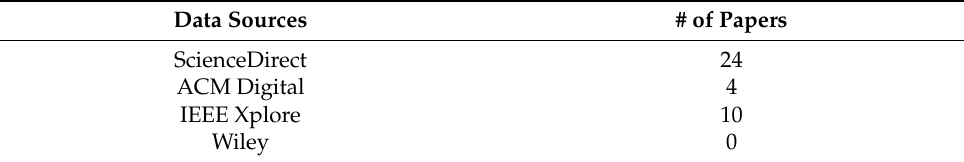
Figure 3. Number of papers per year. Table 5. Paper distributions per journal.